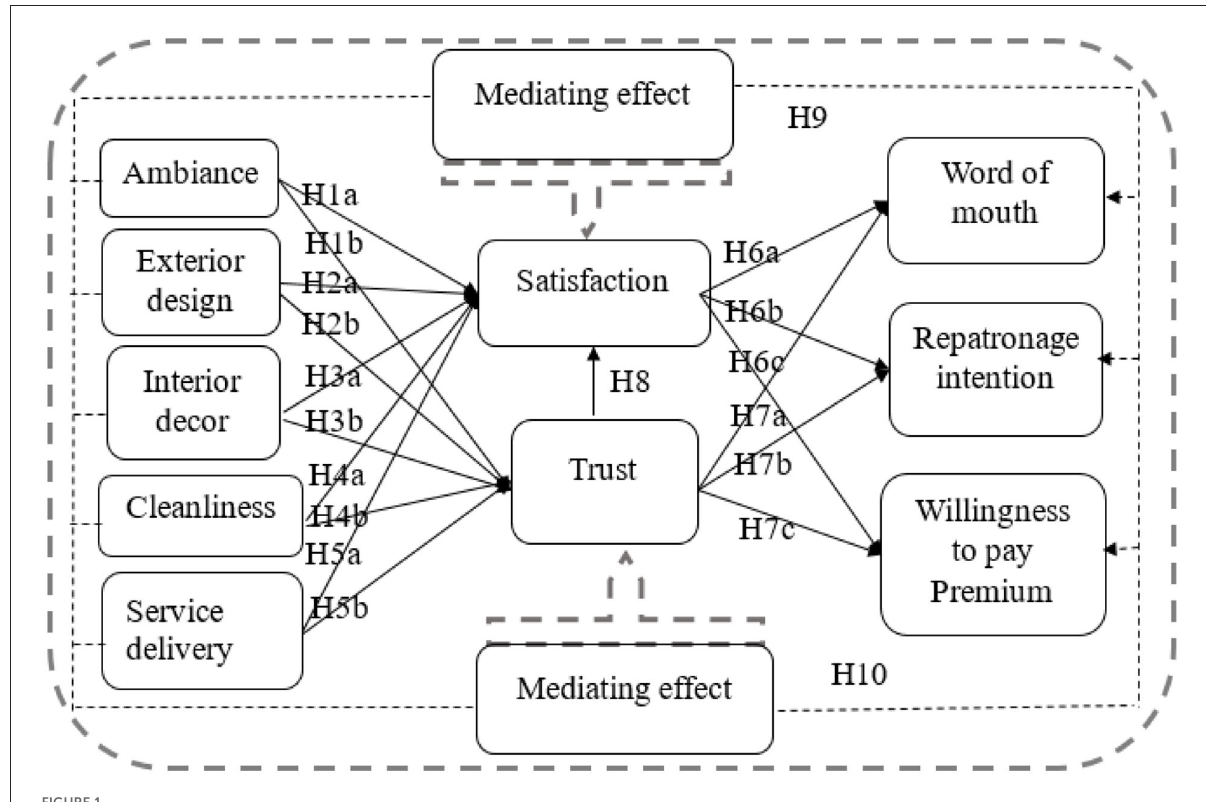
FIGURE1 Conceptual